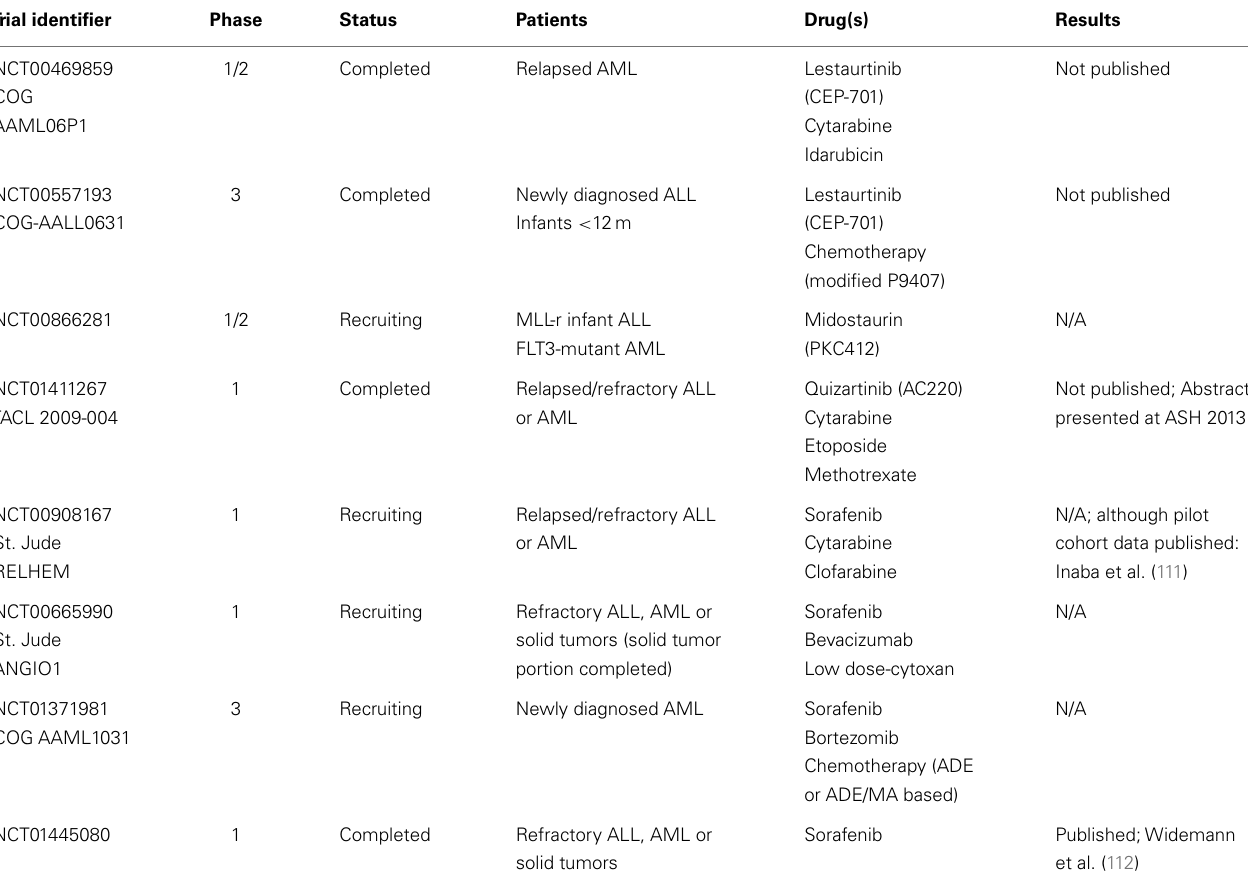
Table 1 | Pediatric clinical trials with FLT3 inhibitors: recently completed or ongoing studies